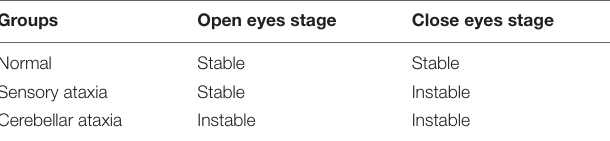
TABLE 1 | Performance of different groups in Romberg’s test.